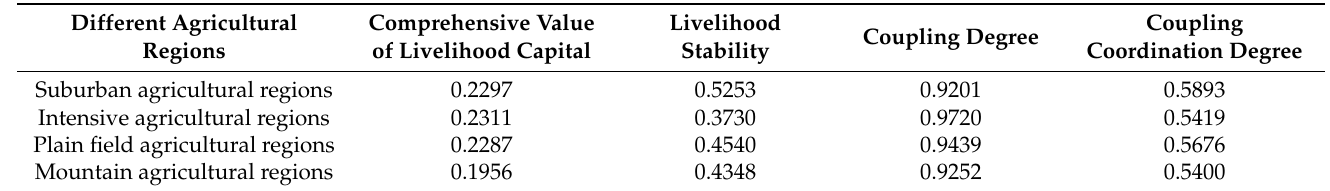
Table 6. Coupling coordination degree of livelihood capital and livelihood stability per household in different agricultural